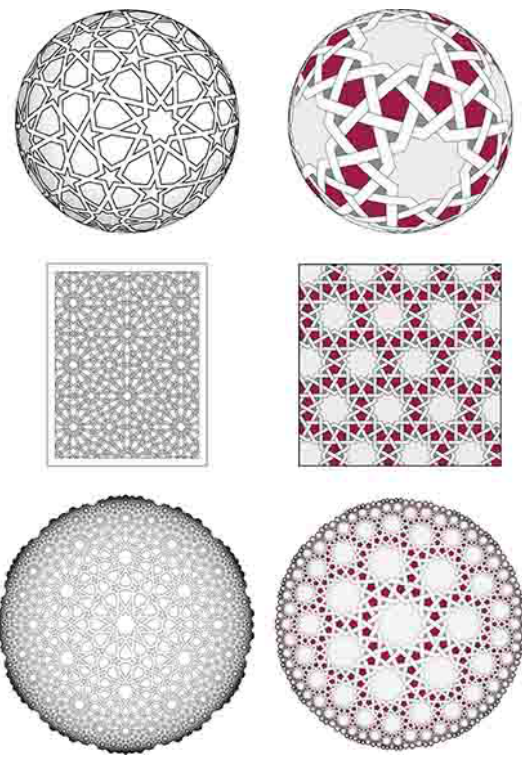
Figure 5: Example of projecting Islamic patterns on a sphere, Eu- clidean, and hyperbolic planes [18].